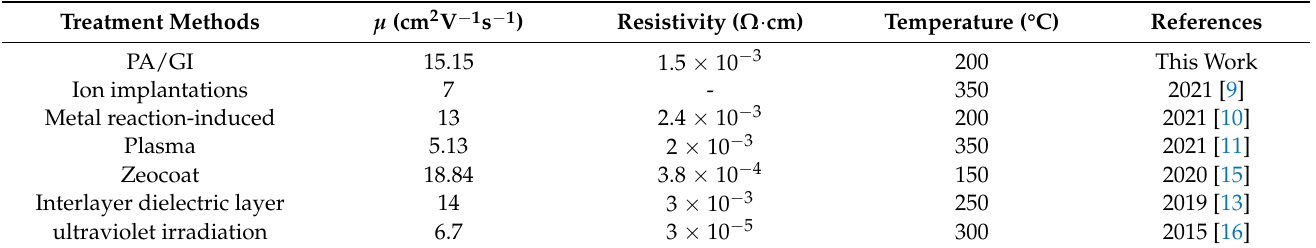
Figure 3. ( a ) Variation of sheet resistance with deposition temperature, ( b ) variation of sheet resistance with placement time, ( c ) R tot -L plot measured from the TFTs with different L at various gate voltage biases, ( d ) width-normalized contact resistance as a function of gate voltage. Table 1. This is a table. Tables should be placed in the main text near to the first time they are